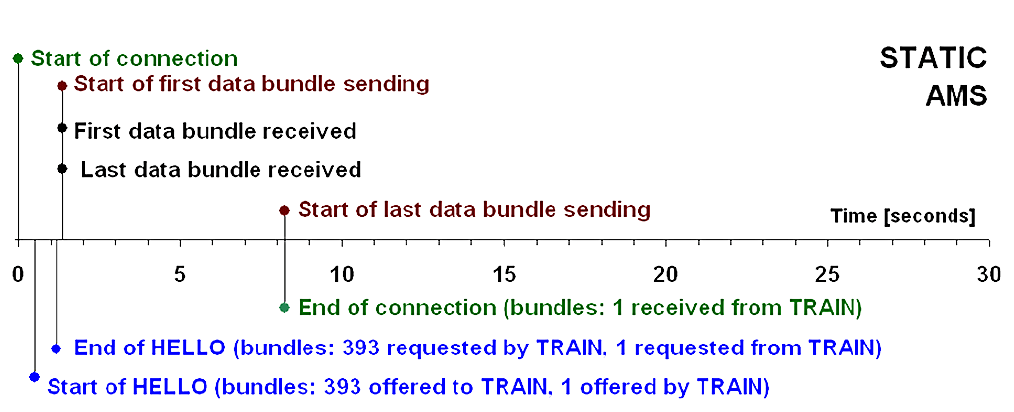
Fig. 9. Timeline of events on the static node (initiator of connection, horizontal timescale in seconds after the start of